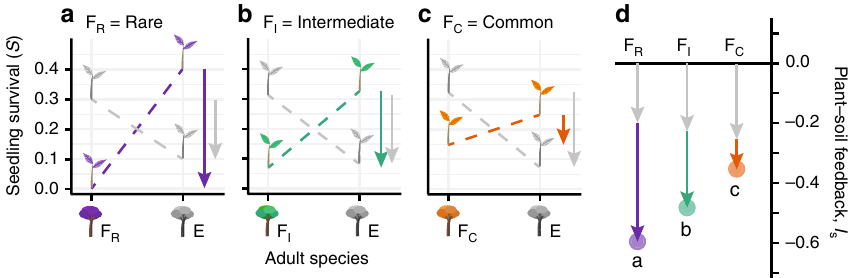
Fig. 1 Plant-soil feedback of focal species (F) vs. all other species (E). Plant-soil feedback can be calculated for a single species by taking the average of all pairwise interaction coef fi cients including that species 6,19 . Using this focal species interaction coef fi cient, and the home-away approach, studies have compared plant-soil feedback values between species that vary in abundance. In multiple systems, common species exhibit less negative PSF than rare species 6,13,56,57 . Above, we illustrate how measured values of seedling survival probabilities can create the relative decrease in the strength of negative PSF that common species often exhibit. Panels ( a ) – ( c ) show hypothetical values of seedling survival for rare, intermediate, and common species, that create a correlation between host relative abundance and the strength of PSF (panel d ). This relative decrease in the strength of negative PSF for common species could either be caused by the accumulation of relatively less detrimental soil biota beneath common conspeci fi cs (i.e. an increase in S a relatively more detrimental soil biota beneath heterospeci fi cs of common plants (i.e. a decrease in S a indistinguishable using metrics of PSF, or conspeci fi c negative density dependence, but they would likely have different implications for plant community